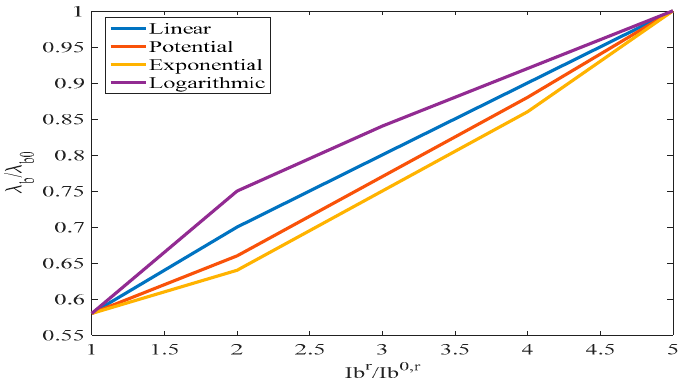
Figure 6. Branch failure rate (pu) versus reactive current component (pu).